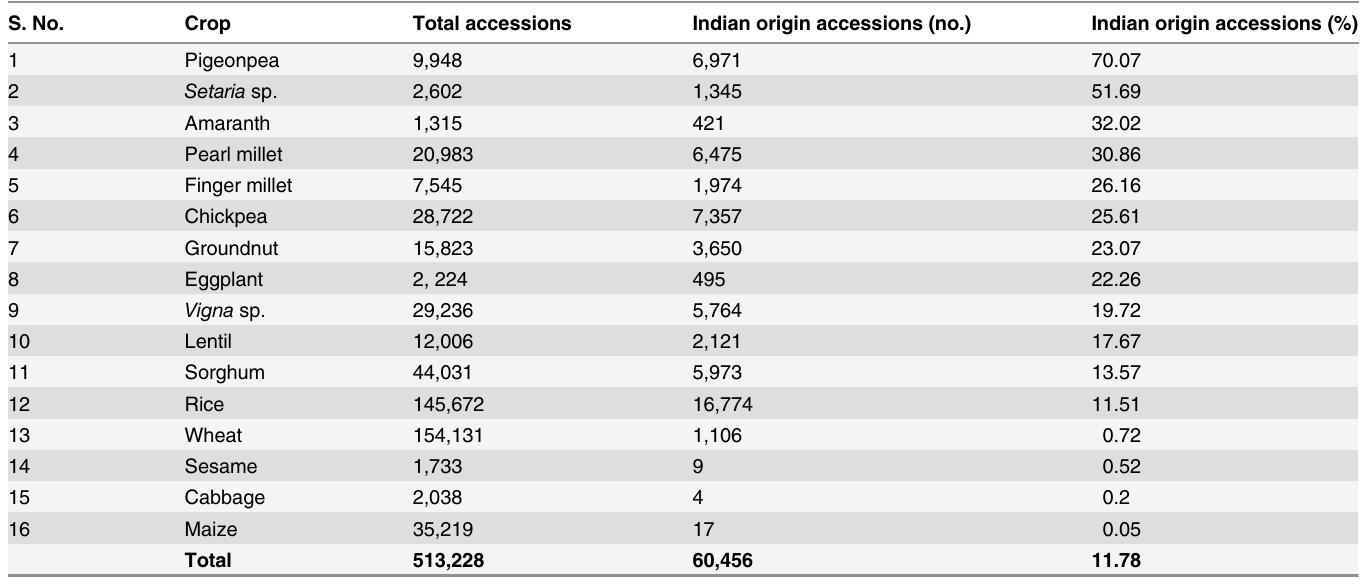
Table 4. Crop-wise details of accessions listed in SGSV database.